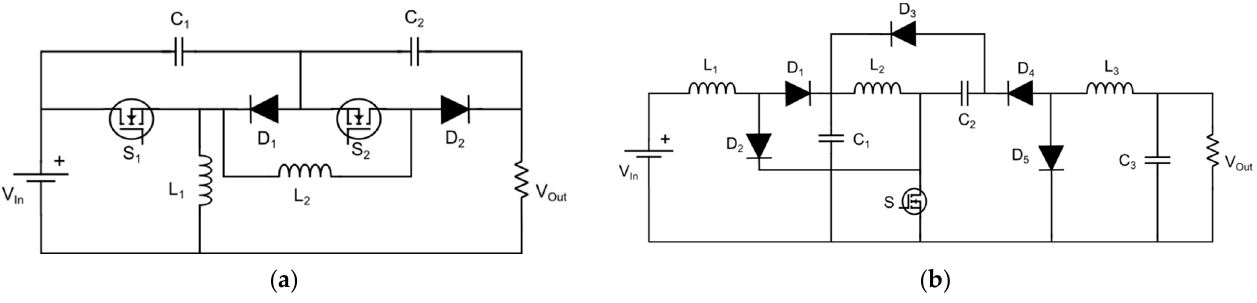
Figure 8. Quadratic buck-boost converter with positive output voltage and continuous input currents (QBBPO) ( a ). Single-switch quadratic buck-boost with both input and output current continuous converter (SSQBB) ( b ).